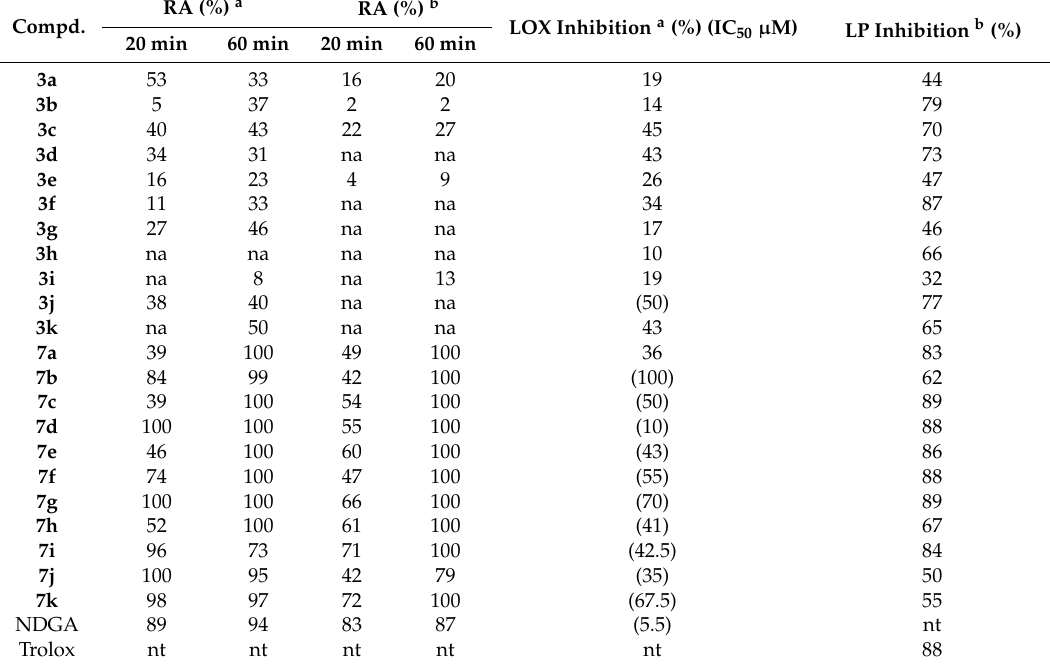
Table 3. DPPH-reducing ability (RA), in vitro inhibition of soybean lipoxygenase (LOX) and lipid peroxidation